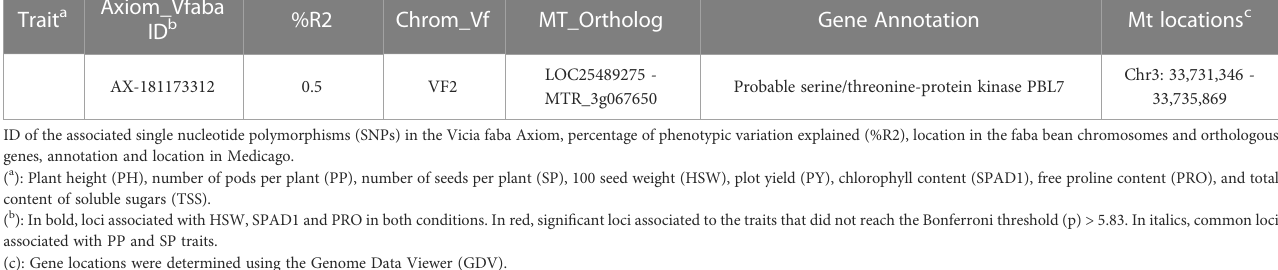
each trait across different water regimes (Tables 2 and 3). The manhattan and their corresponding quantile-quantile (Q-Q) plots run with the MLMM method are shown in Figures 5 and 6. Q-Q plots revealed that the -log10 (p-values) for the different traits evaluated under each water regime condition conformed to normal distribution. TABLE 3 List of candidate genes related to drought resistance traits. Axiom_Vfaba Trait a ID b